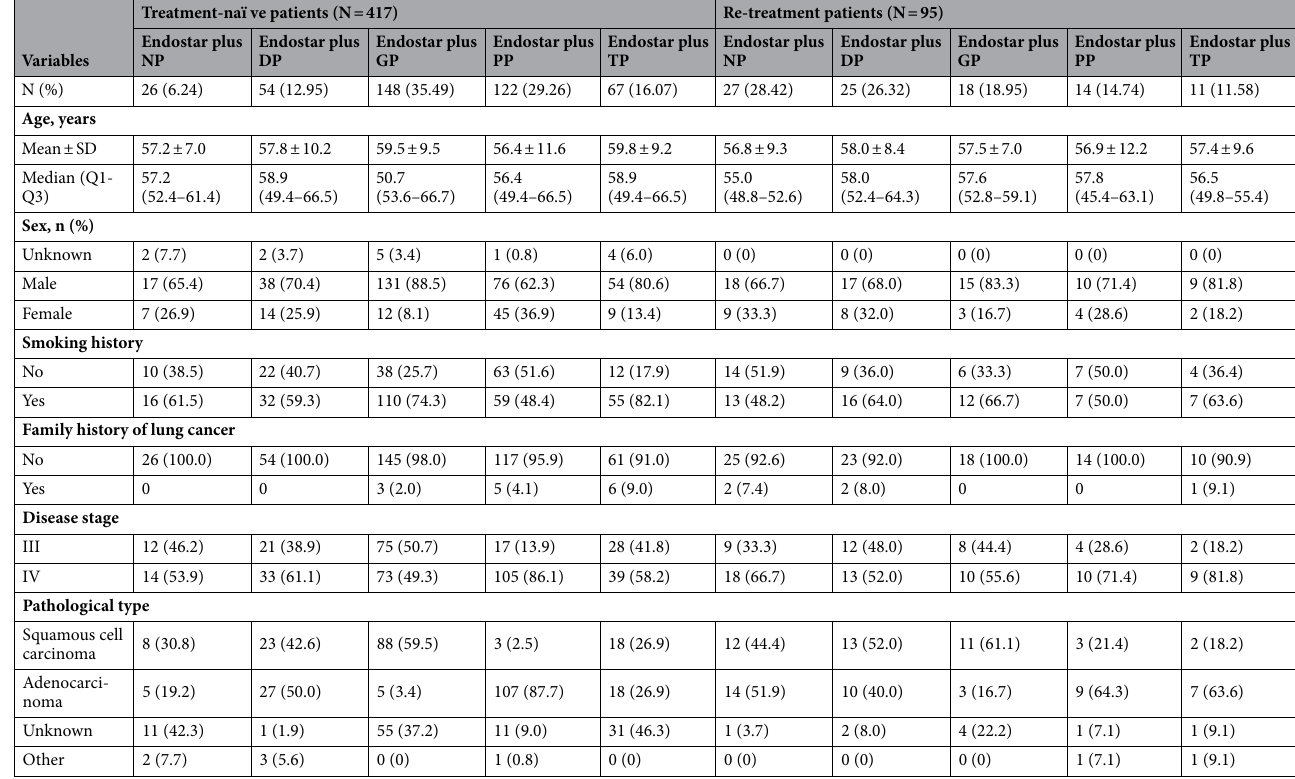
Table 2. Real-world treatment pattern and baseline characteristics of Endostar plus different chemotherapy in treatment-naïve and re-treatment patients.